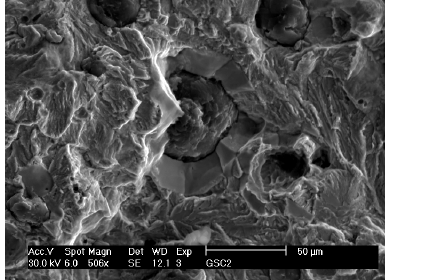
Figure 43: Ferritic-pearlitic DCI (R = 0.75,  K = 8 MPa √ m).